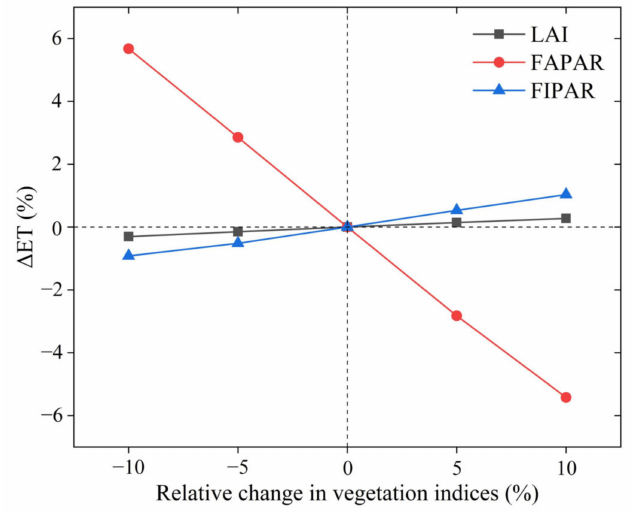
Figure 11. The model sensitivity to changes in vegetation variables (LAI, FAPAR, and FIPAR) for the PT-JPL model. The larger the slope of the line, the more sensitive the model is to the change in vegetation variable. ∆ ET: The relative difference in ET simulations